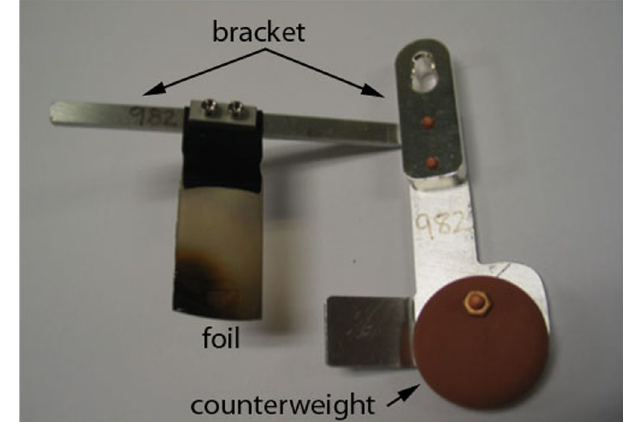
FIG. 2. A used second-generation foil bracket. The beam power in this case was only 400 kW, so this foil and bracket show very little damage. (The figure was reproduced from Ref.